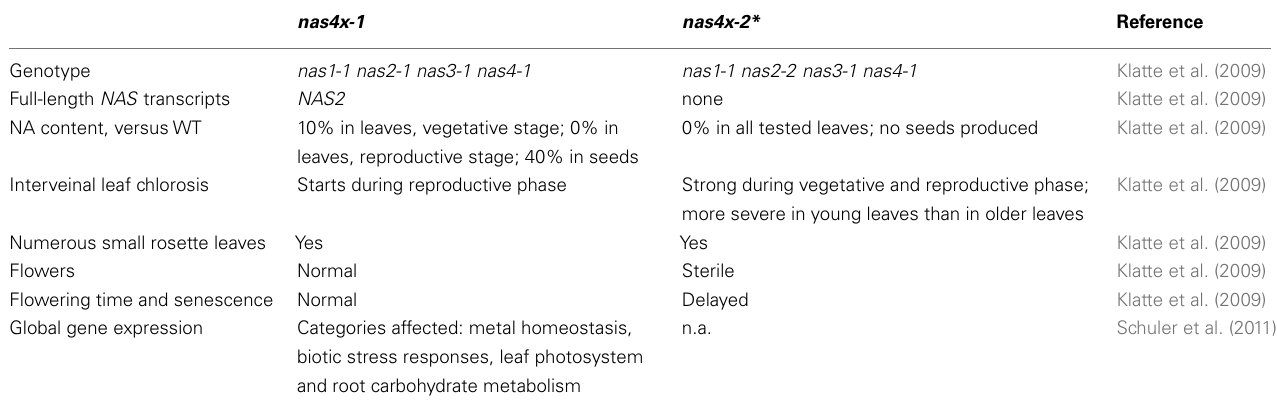
Table 1 | Comparison of nas4x-1 and nas4x-2